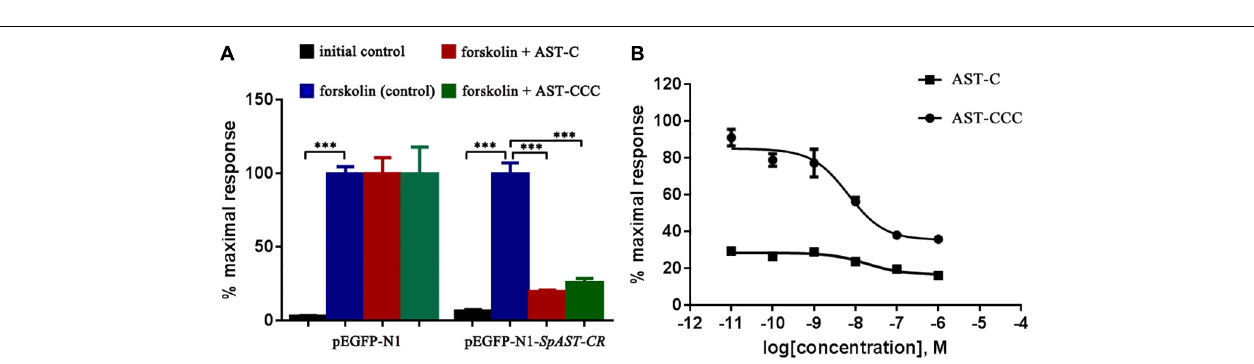
FIGURE 1 | Expression and localization of Scypa AST-CR-EGFP in the HEK293T cell. (A) Nucleus labeled by DAPI (blue); (B) Scypa AST-C-EGFP; (C) cell membrane stained by Dil (red); (D) merge.